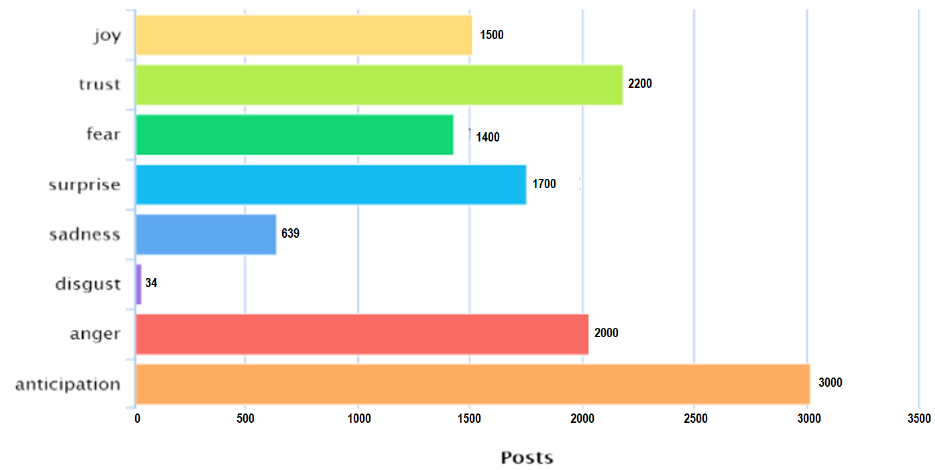
Figure 4. Emotional analysis of discussions on LSSR.